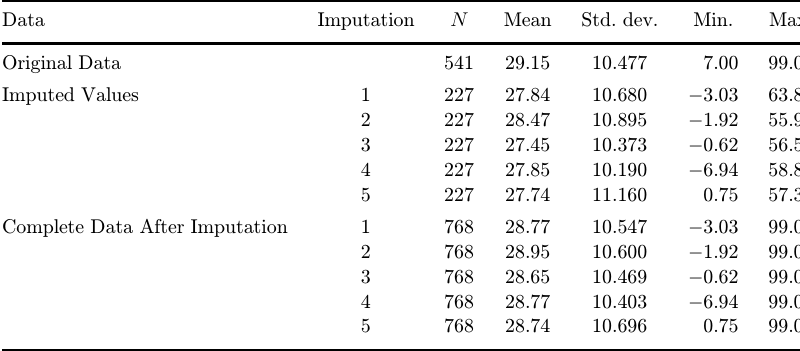
Table 4. Multiple imputations for V